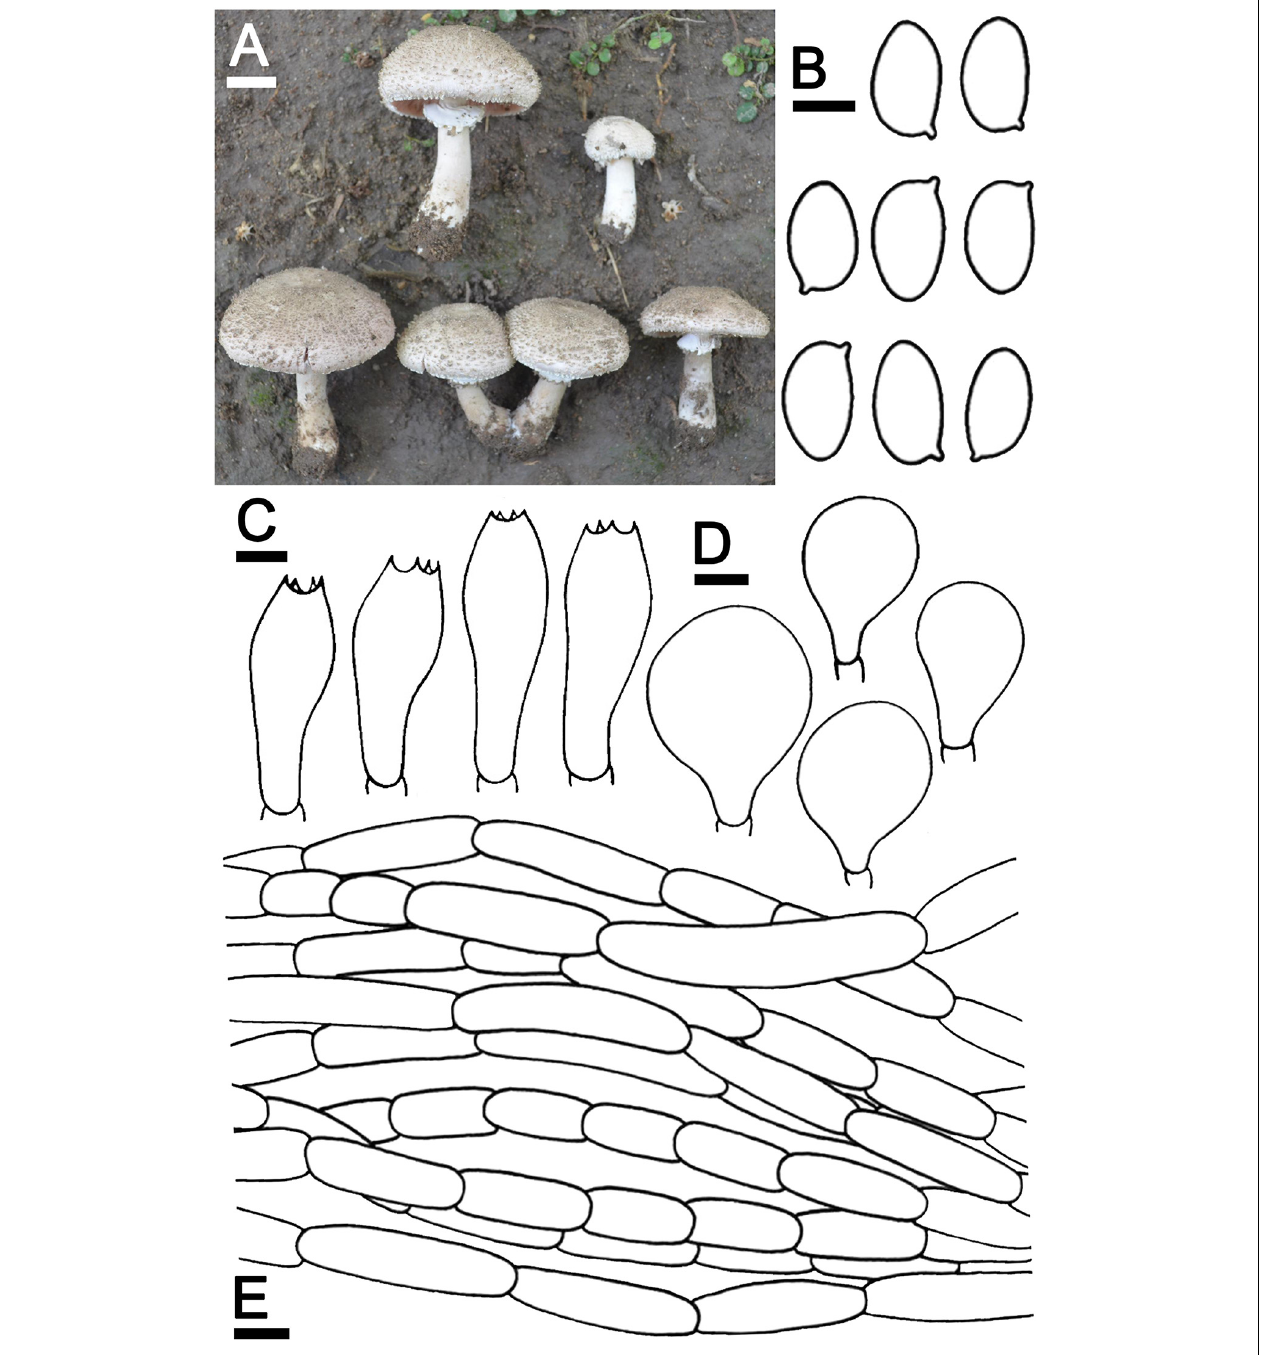
FIGURE 4 | Agaricus pseudoerectosquamosus SDBR-NK0064 (holotype). (A) Basidiomata on the field, (B) Basidiospores, (C) Basidia, (D) Cheilocystidia, (E) Pileipellis. Scale bars (A) = 2 cm and (B–E) = 5 µ